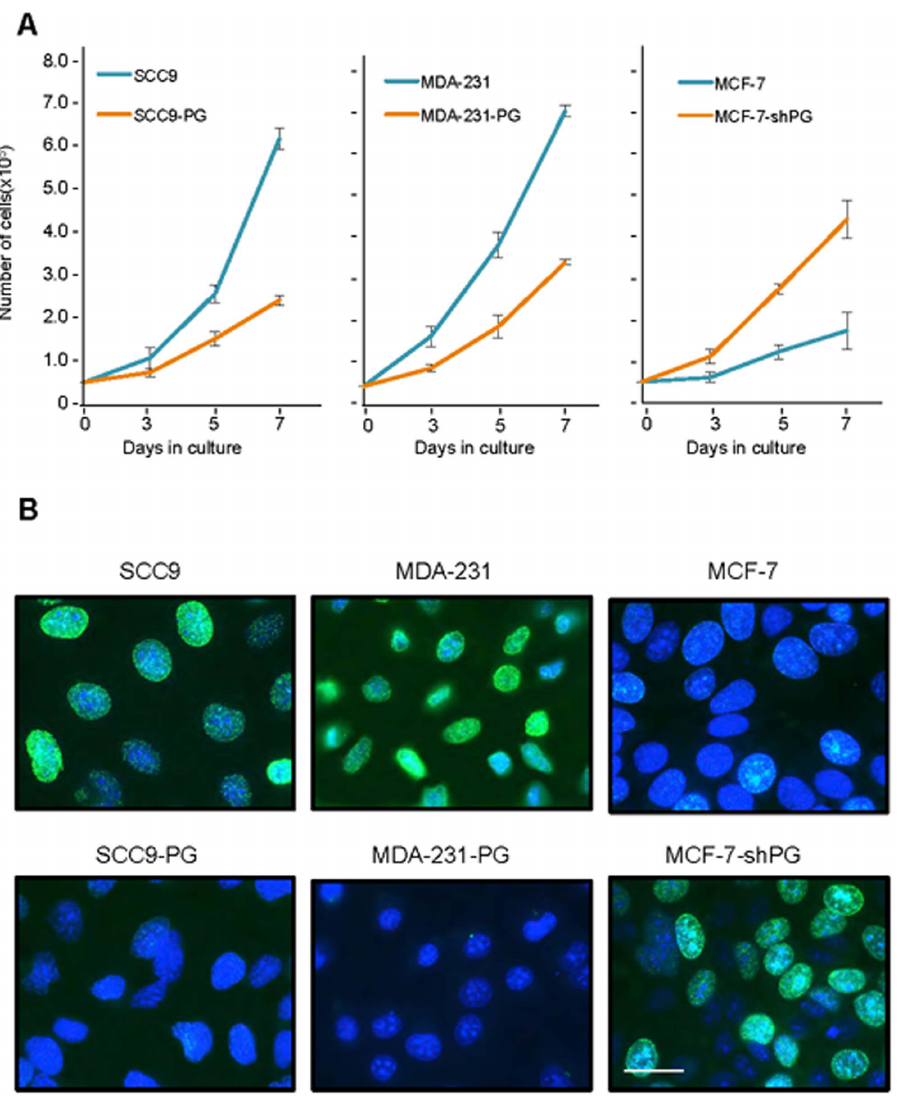
Figure 5. Plakoglobin decreases invitro cell growth and proliferation. A. Replicate cultures of SCC9, SCC9-PG, MDA-231, -231-PG, MCF-7 and MCF-7-shPG cells were established at single cell density and cells were counted at 3, 5 and 7 days. Each time point represents the average of three independent experiments. The absence of error bars at some time points is due to the small differences among the experiments. B. SCC9, SCC9-PG, MDA-231, -231-PG, MCF-7 and MCF-7-shPG cells were plated on glass coverslips and allowed to grow for 6 days at which time BrdU was added to the cell cultures for 24 hours. BrdU incorporation was then assessed by immunofluorescence staining using BrdU antibodies. Nuclei were countersatined with DRAQ5 and cells viewed using a 63X objective of an LSM510 META (Zeiss) laser scanning confocal microscope. Bar, 20 m